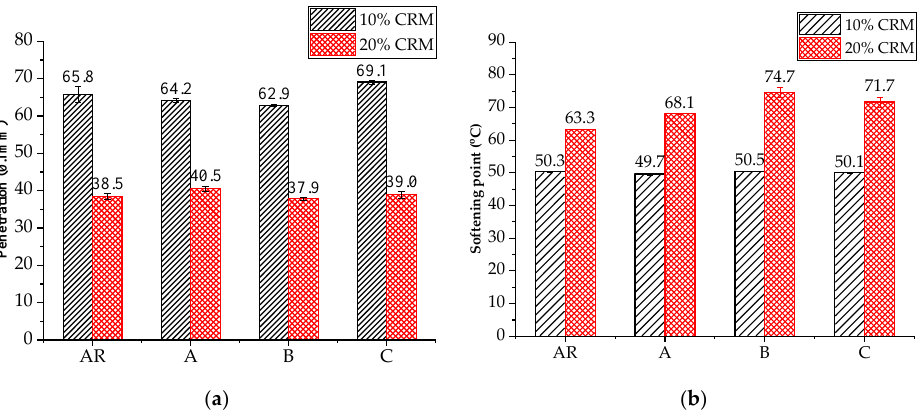
Figure 3. Physical properties of asphalt binders: ( a ) penetration; ( b ) softening point.